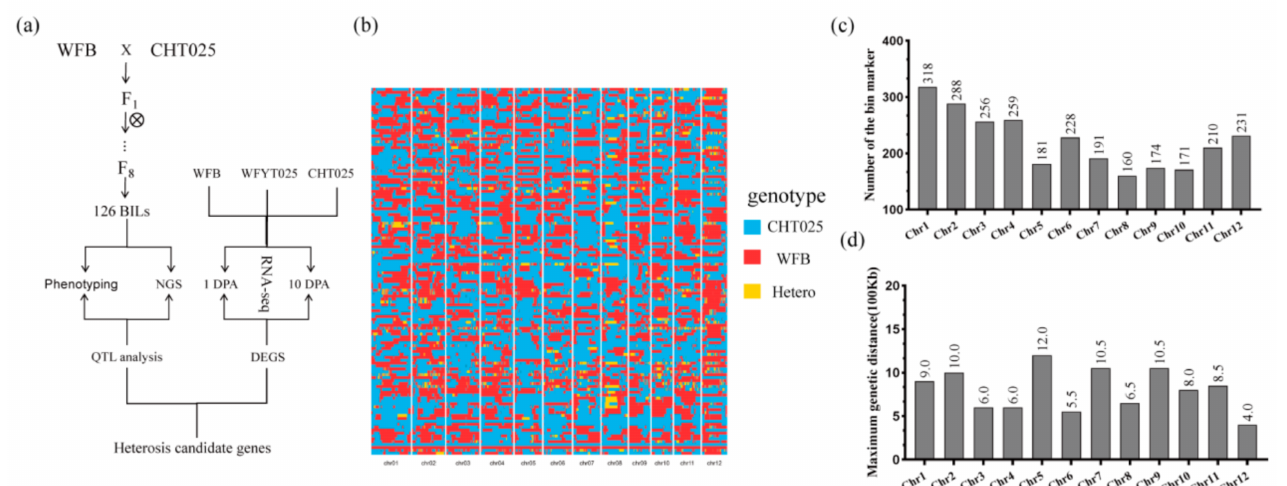
Figure 6. Schematic overview of RILs system construction, and using RNA sequencing studies, the transcriptional dynamics of grain development. ( a ) The technology road-map using quantitative trait locus (QTL) analysis of 126 RILs and combining RNA sequencing data at 1 and 10 days post- anthesis grain development in rice to uncover heterosis-related loci for grain shape and grain weight (Blue refers to the genotype of CHT025, red refers to the genotype of WFB, and yellow refers to hetero). ( b ) Graphic genotypes of 126 RILs were identified by a sliding-window approach along each chromosome. Various colors represent different genotypes. ( c ) The number of bin markers on each chromosome. ( d ) Maximum marking distance (100 Kb) on each